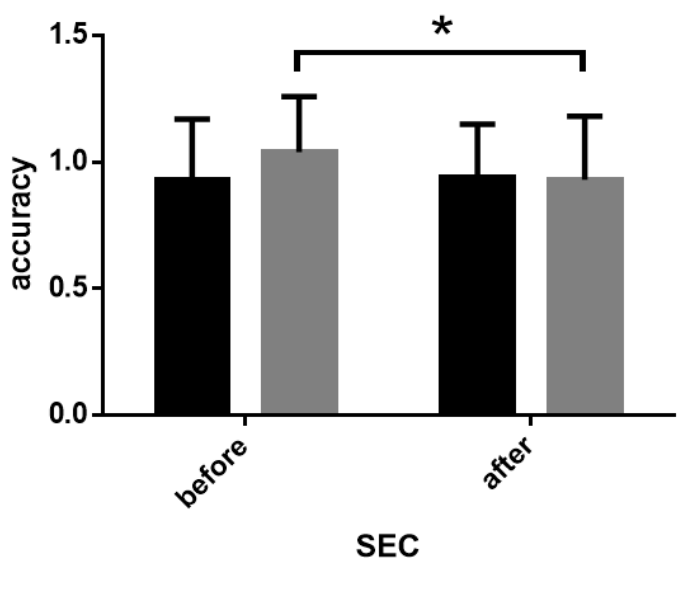
Figure 8. Social emotional cognition (SEC) task scores before and after intervention. Social cognition was evaluated by the SEC task; SEC scores were assessed by accuracy rate (the proportion of correct responses). Changes in SEC scores did not reach significant level in CCAT group (P=.56), whereas the accuracy rate decreased significantly in the control group (P=.02) as reflected by the asterisk. CCAT: computerized cognitive addiction therapy.